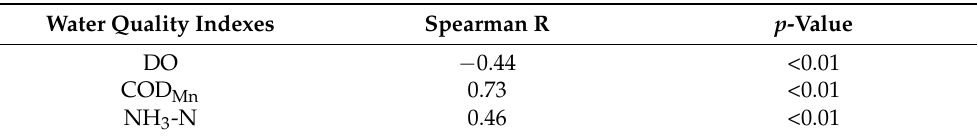
Figure 14. Scatter plot of DO ( a ), COD Mn ( b ), NH 3 -N ( c ) concentration, and Q-value. The red line is a linear fitting line. The dark-red shaded area is the 95% confidence interval, and the light-red shaded area is the 95% prediction interval. Table 5. Relation between Q-value and water quality